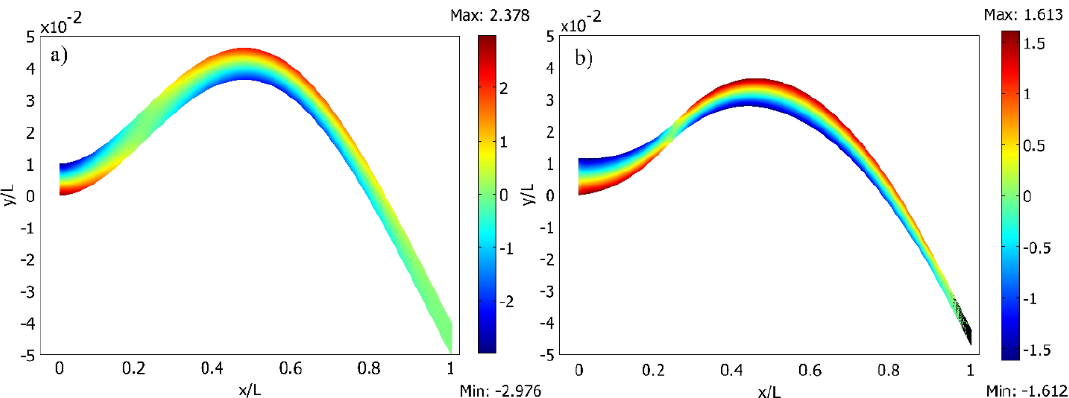
Figure 4. The second transverse vibration mode of the cantilever and the field of normal strain distribution: ( a ) cantilever of a constant cross-section; ( b ) optimally-shaped cantilever.